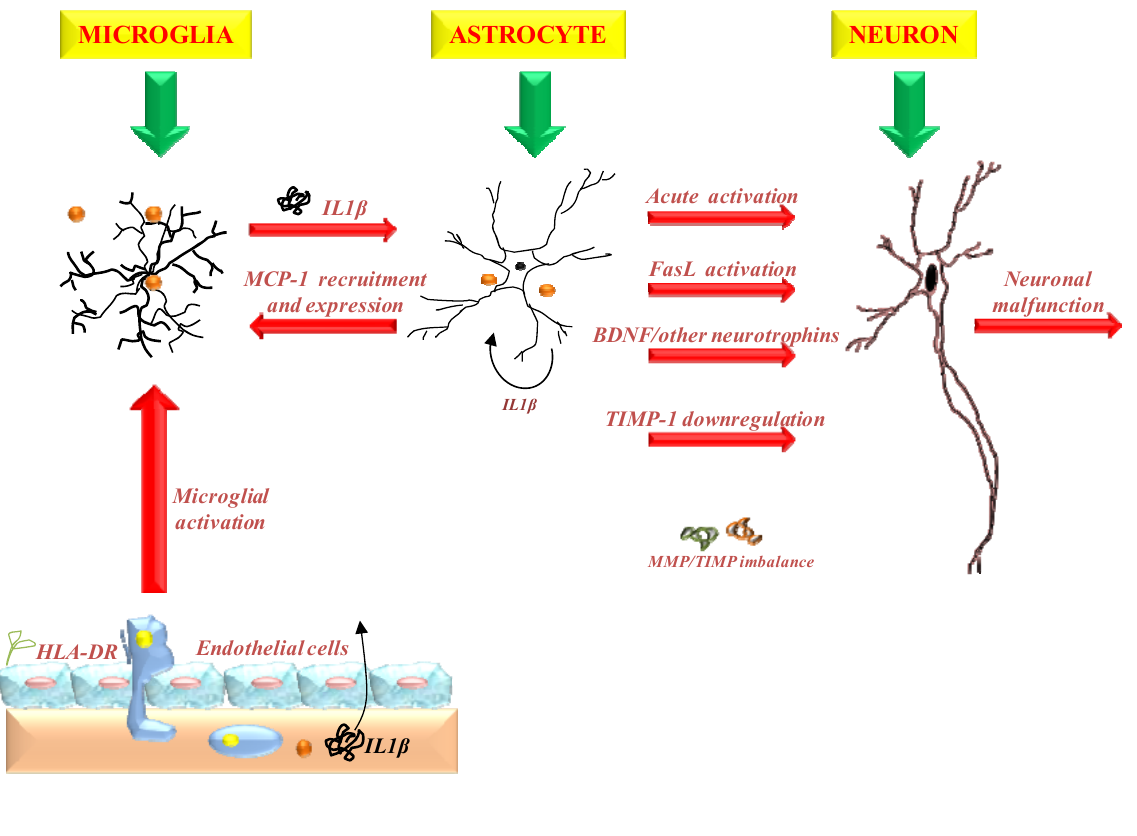
Figure 2. The role of glial cells in central nervous system inflammation and neurodegeneration. BDNF = brain-derived neurotrophic factor, MP = macrophages, MMP = membrane metalloproteinase, TIMP = tissue inhibitors of metalloproteinase (Adapted from: Ghorpade et al.